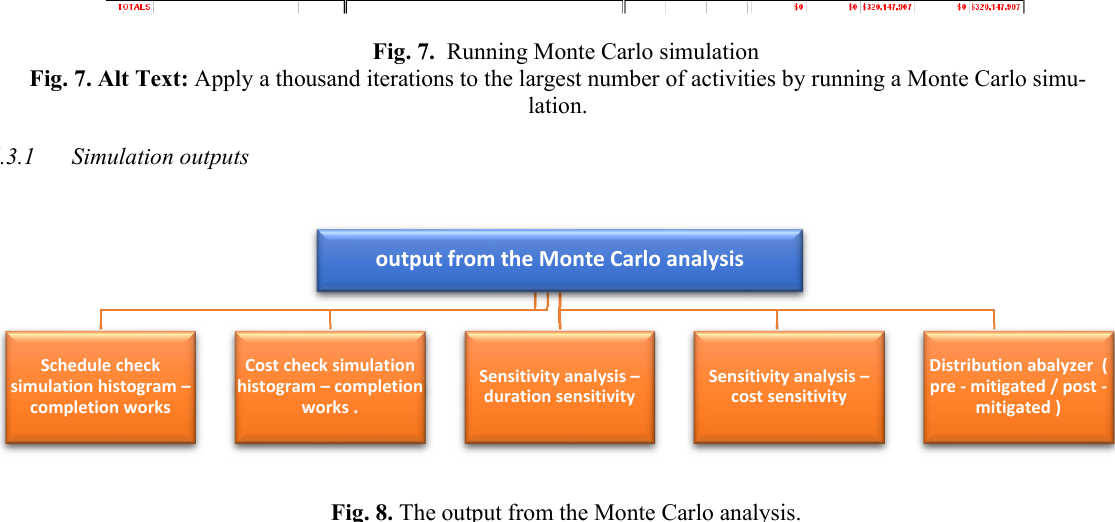
Fig. 8. The output from the Monte Carlo analysis. Fig. 8. Alt Text: shows the output from the Monte Carlo analysis: Schedule check simulation histogram, Cost check simulation histogram, Sensitivity analysis, and distribution analyzer ( pre - mit-